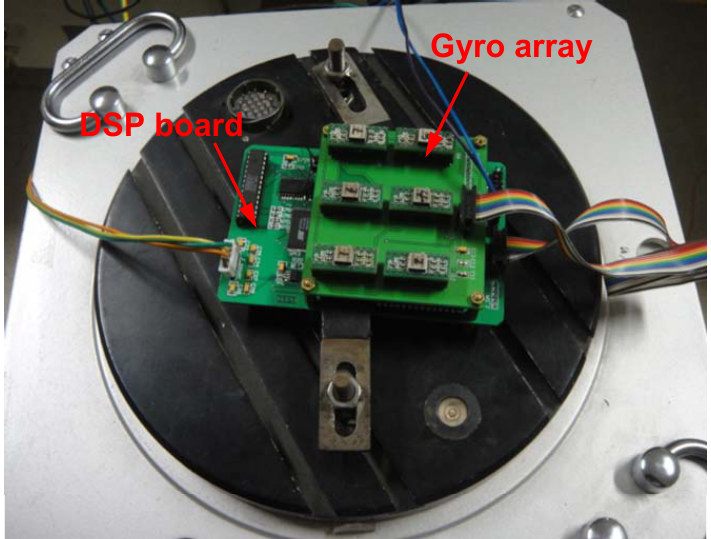
Figure 4. A p rototype of the virtual gyroscope